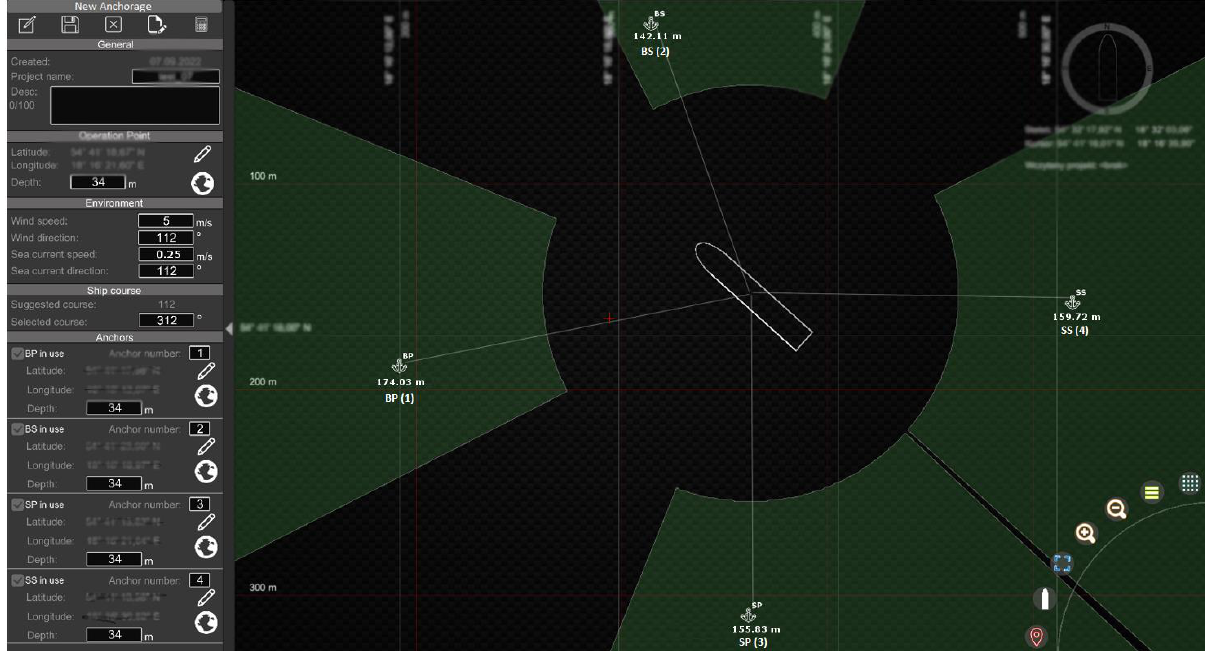
Figure 9. Sea current speed values for Gdansk Bay on 19 May 2022 [25].